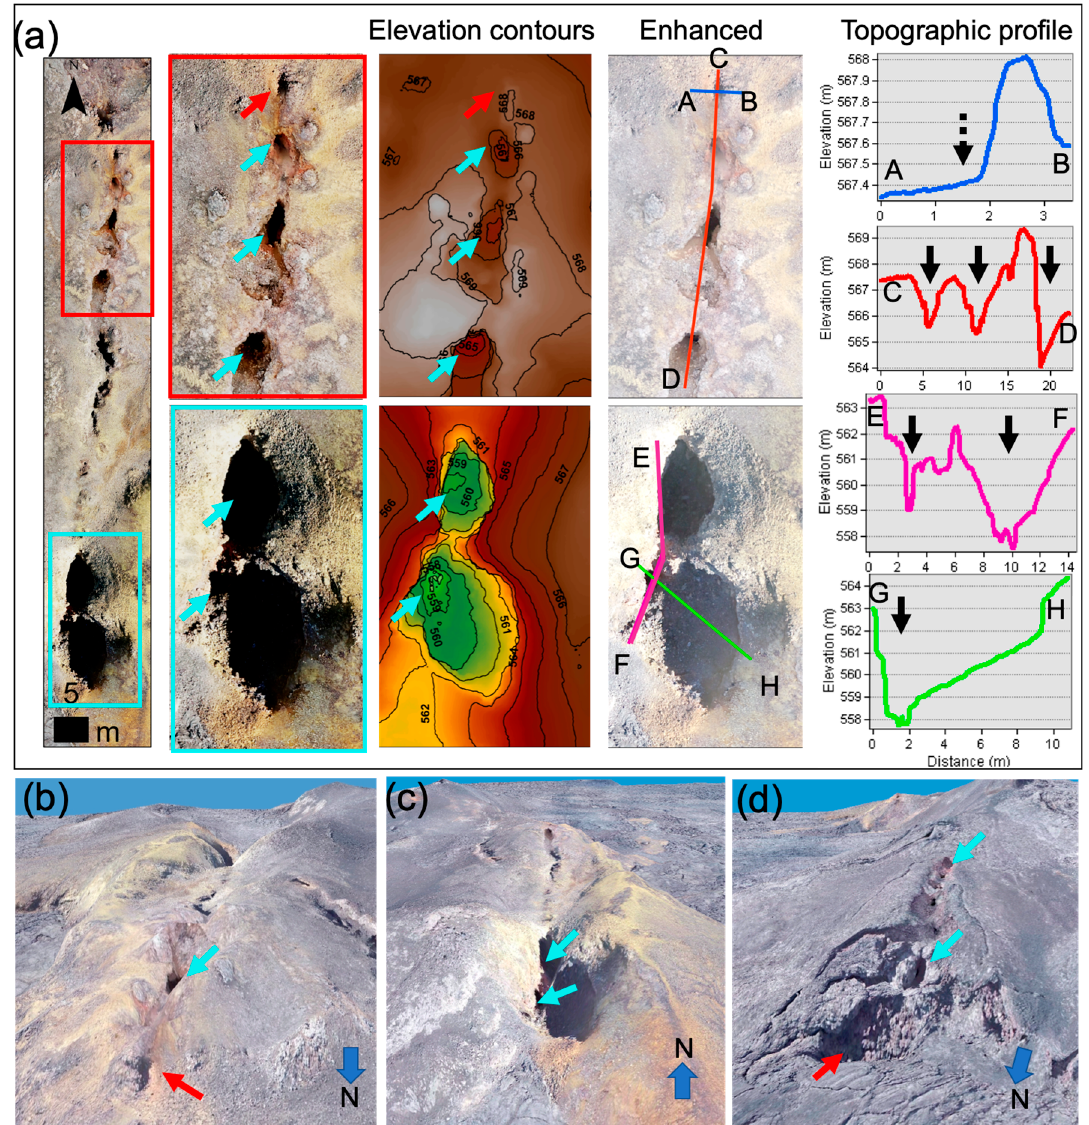
Figure 3. Cave opening identification strategy: ( a ) our systematic approach using DTM and contours, histogram enhanced image, and topographic profiling for identifying cave openings, illustrated here for a collapsed lava channel; ( b ) use of 3D perspective view to confirm the dark pixels (red arrow) in orthomosaic shown within the red rectangle in ( a ) as a shadow caused by topography, whereas the cyan arrow depicts one of the possible cave openings; ( c ) use of 3D perspective view to confirm the dark pixels (cyan arrows) in orthomosaic shown within the cyan rectangle in ( a ) as cave openings; ( d ) 3D perspective view of another collapsed lava channel with openings and shadows. Cyan and black arrows in all the figures represent confirmed cavities in images and profiles, respectively. Red and dotted black arrows show spots that are not cave openings, but are shadows caused by topography in images and profiles, respectively.